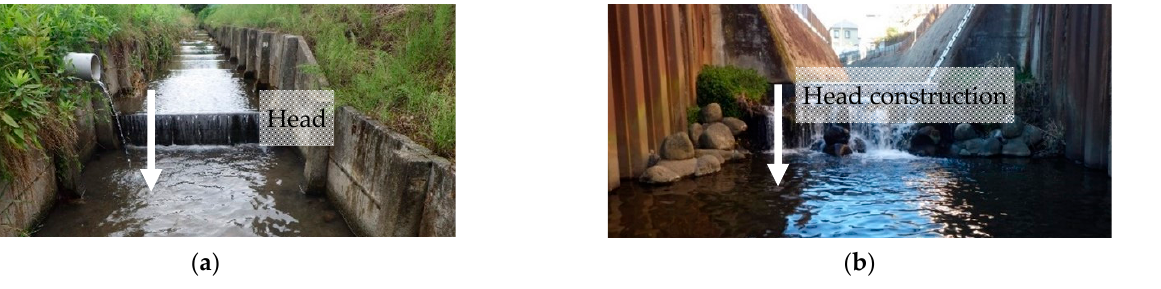
Figure 2. Examples of the places where the continuity of the upstream movement of fish is interrupted by the head: ( a ) The head of a waterway that interrupts the upstream movement of fishes; ( b ) The head construction of a small size river that interrupts the upstream movement of fishes.